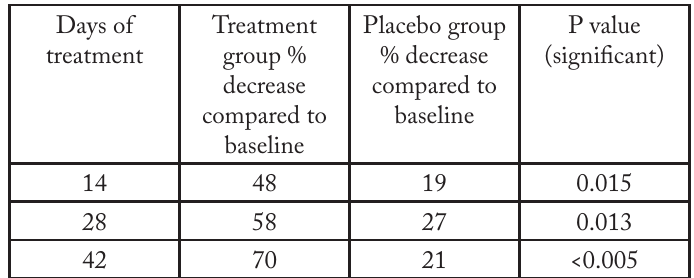
Table 3: Summary of the % decrease in compulsive behaviour of dogs in the fluoxetine treatment and placebo group compared to baseline. Significant P value reported from c2 statistical